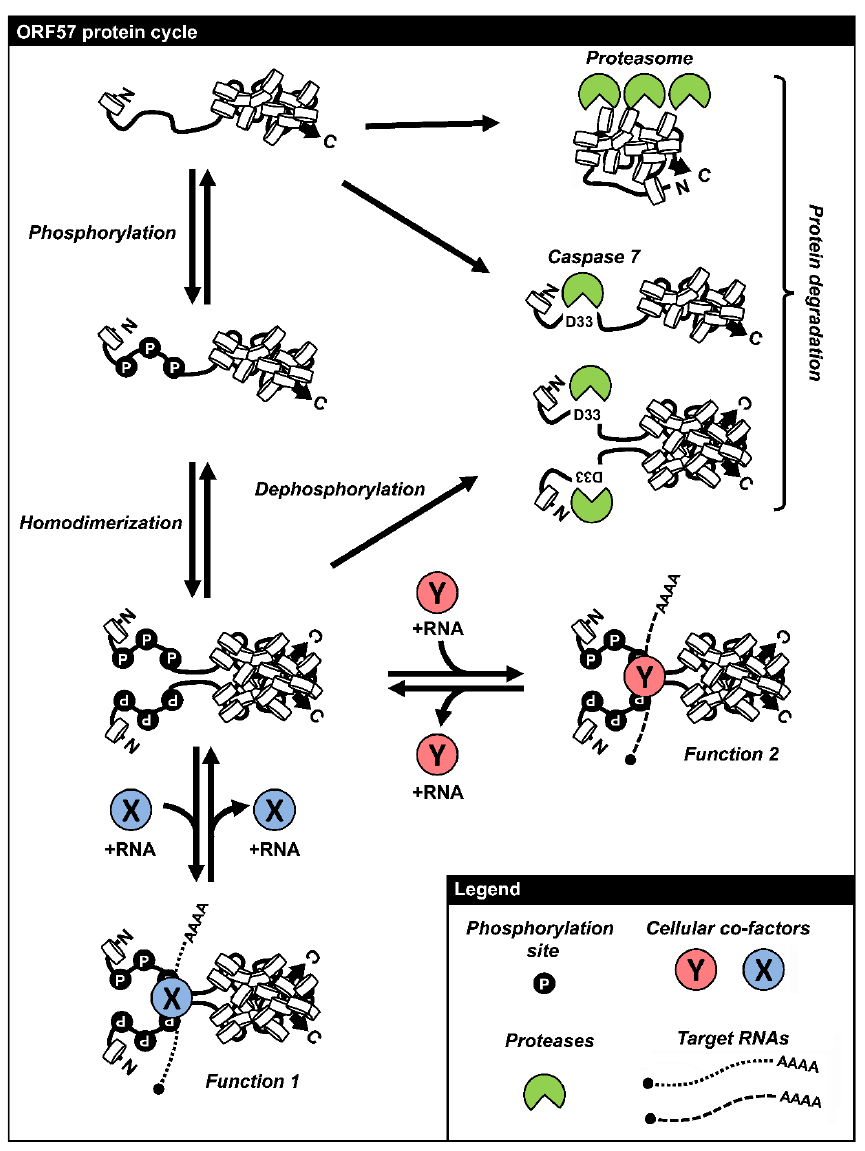
Figure 5. The life cycle of ORF57 protein. KSHV ORF57 features an intrinstically disordered N -terminal domain and a highly structured C -terminal domain. This protein is translated initially as a monomeric protein and undergoes the protein N -terminal phosphorylation by host CKII or other kinases. The monomeric form of ORF57 subjects to cleavage by caspase 7 or degradation via proteasomal pathway. Two phosphorylated monomeric ORF57 polypeptides dimerize through the C -terminal α-helixes 7–9, resulting in the formation of an ORF57 homodimer. ORF57 homodimers interact with cellular protein-RNA complexes to exert various functions of ORF57 and otherwise may subject to caspase 7 digestion. This figure is reproduced with permission from